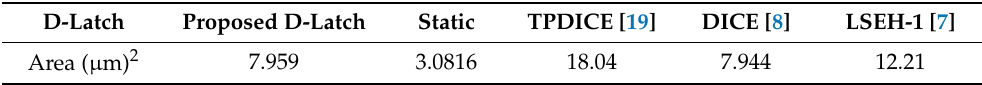
Table 2. Comparative area of